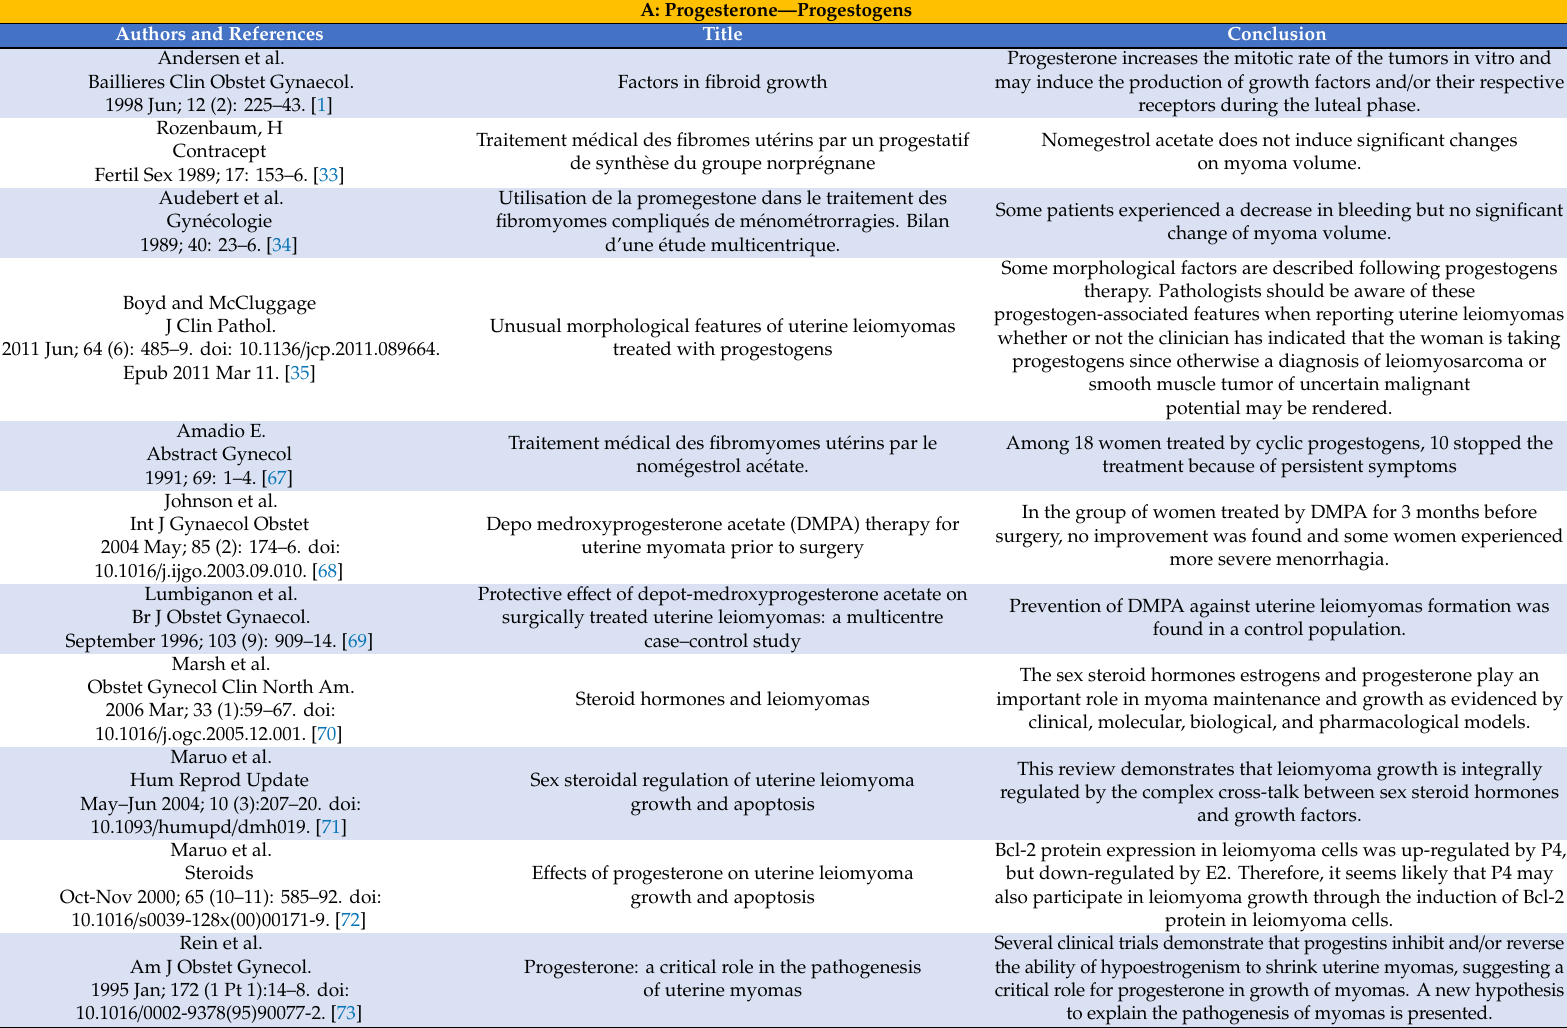
Table 1. Describe the most relevant studies on the